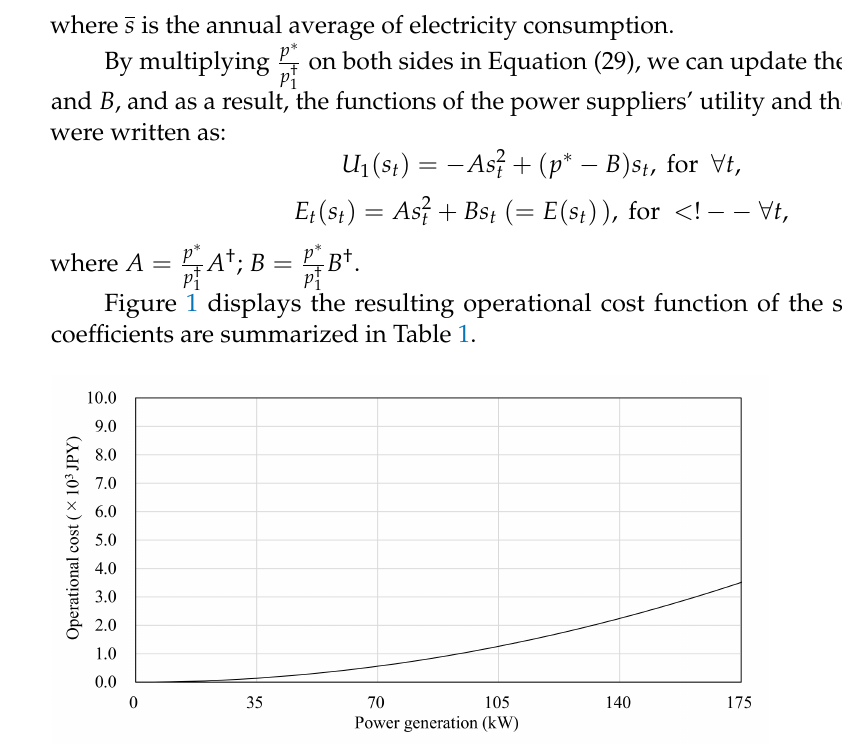
Figure 1. Operational cost function. Table 1. Coefficients in Figure